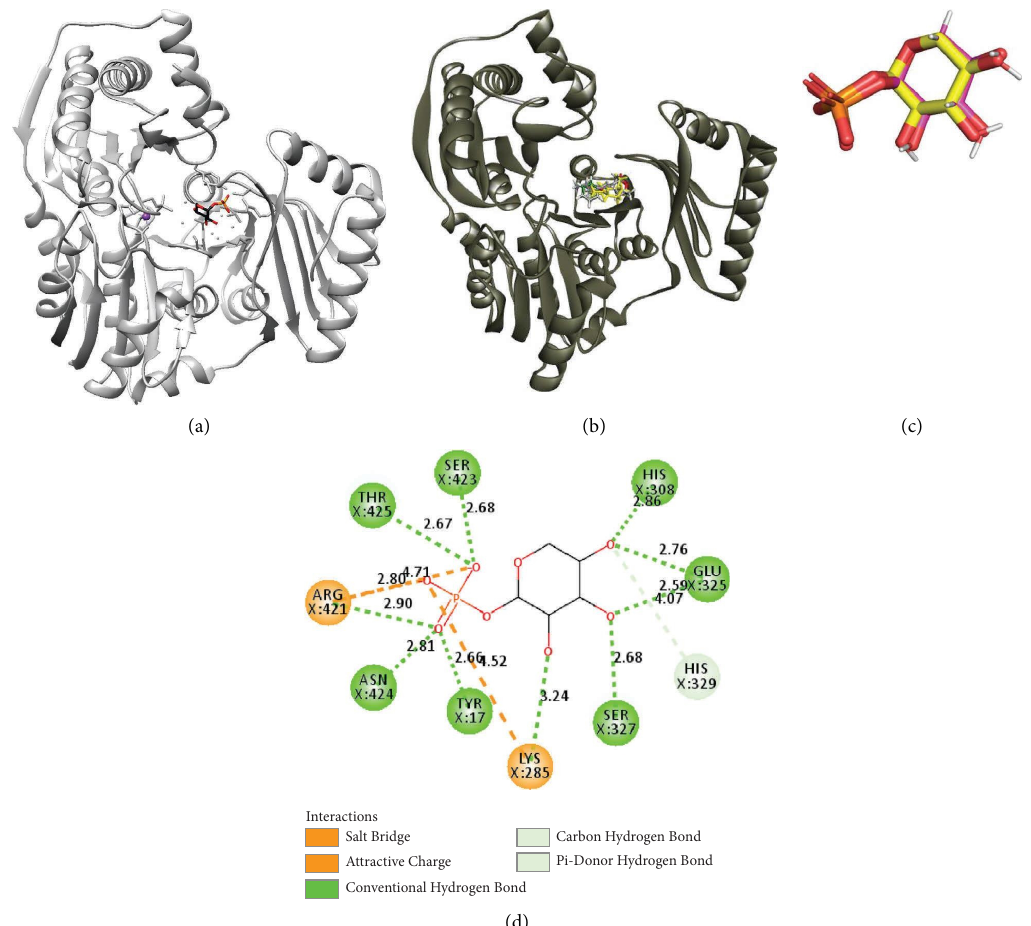
(d) Figure 5: Te phosphomannomutase/phosphoglucomutase enzyme in Pseudomonas aeruginosa , algC: —(a) crystal structure of algC enzyme in complex with xylose-1-phosphate (in black is xylose-1-phosphate and Mg metal in purple); (b) global docking of compounds from the essential oils of V. doniana showing the compounds which preferred to bind in the xylose-1-phosphate binding pocket of the enzyme; (c) superimposition of redocked and crystallized poses of xylose-1-phosphate against algC. Crystallized pose is in yellow and redocked pose is in pink. An RMSD of 0.082 ˚A was observed. Redocking of xylose-1-phosphate produced a binding afnity of − 7.0kcal/mol; (d) 2D interactions of xylose-1-phosphate at the algC active Table 9: Binding free energies and molecular interactions of some selected compounds docked against the algC protein. Compound